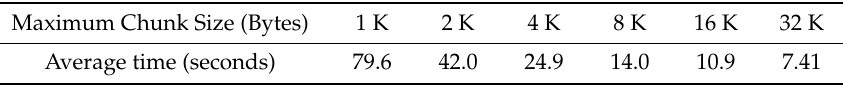
Table 4. Experimental results of storing an inspection report in the blockchain.